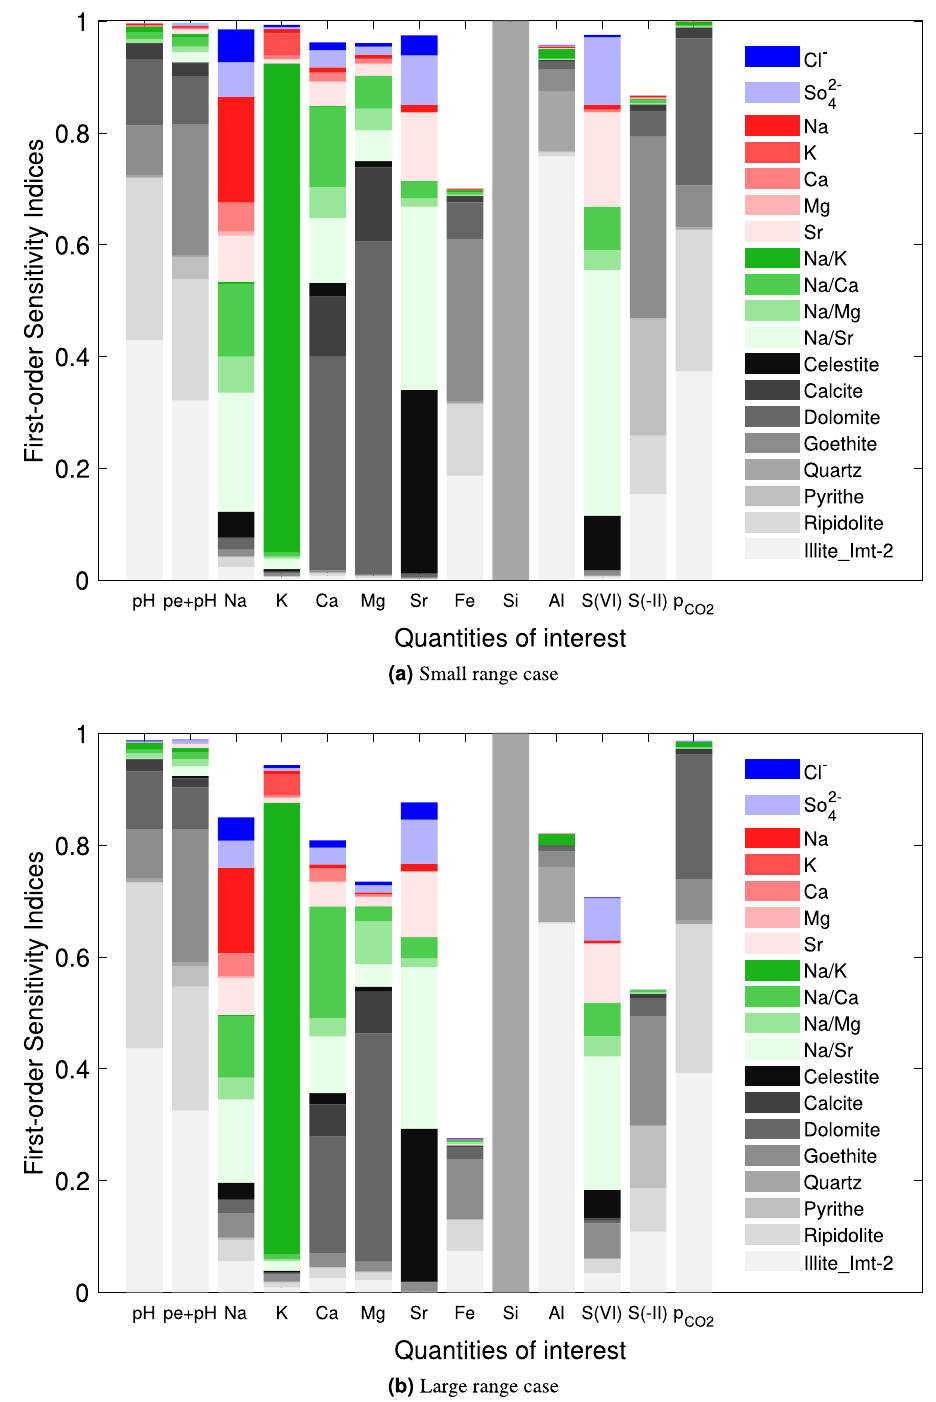
Figure 5. First-order sensitivity indices S i (own effects). The color depends on the input parameter category: blue for the leached parameters, red for the exchanged cations, green for the selectivity coefficients, and gray for the solubilities. The color shade varies within each